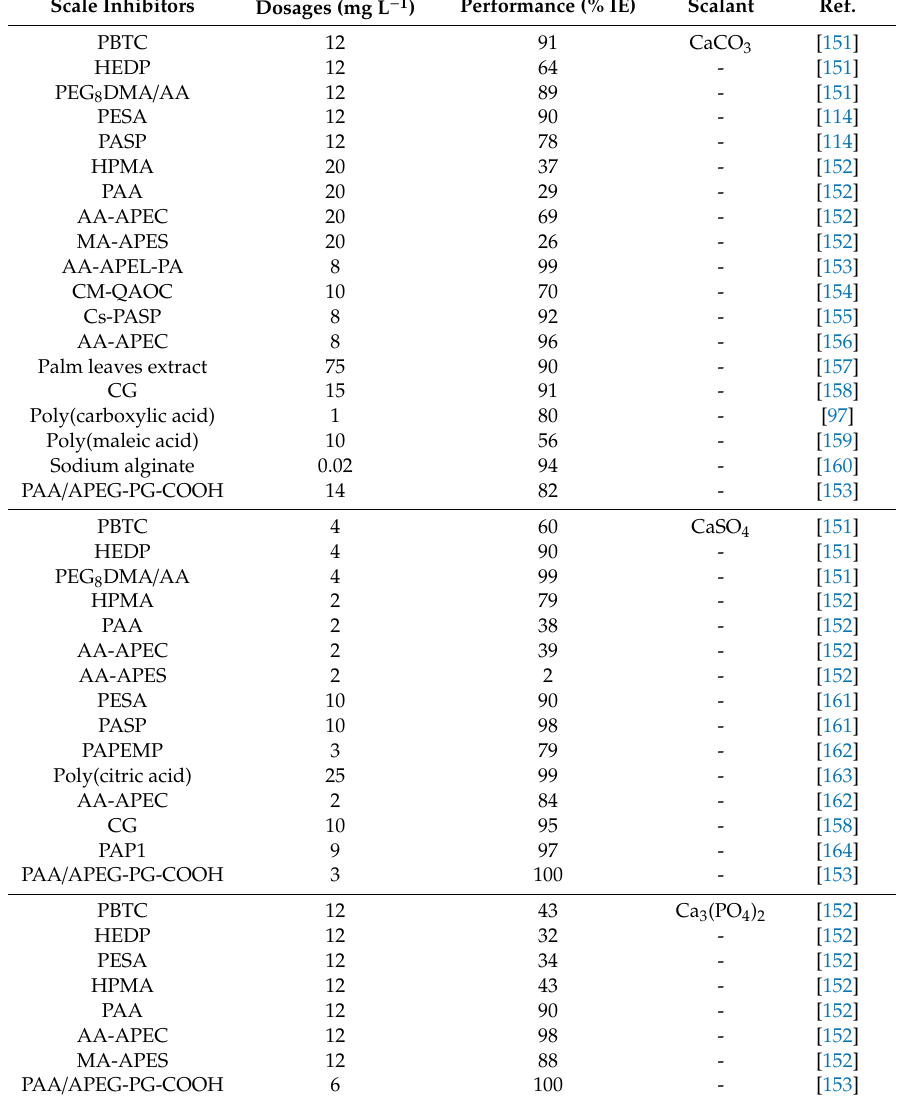
Table 4. List of some conventional and green scale inhibitors and their e ff ectiveness as